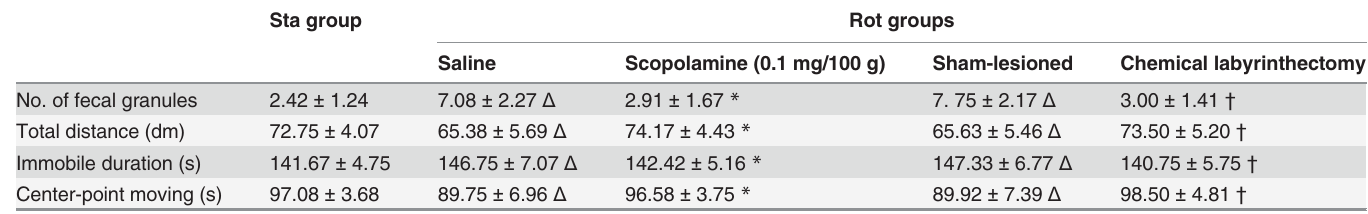
Table 1. MS symptoms observed in animals receiving static control or rotation